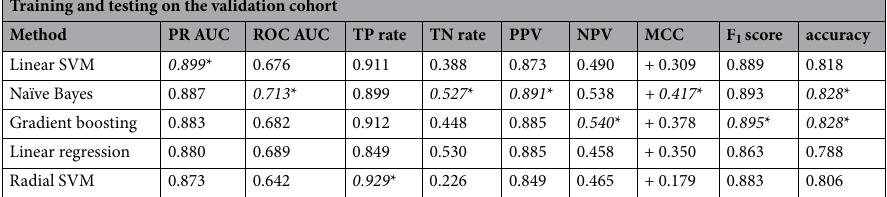
Table 6. Results of the survival prediction made with machine learning classifiers on the South Korean external validation cohort 96 . Mean results of 100 executions with random selection of the elements in the training set and test set, with ROSE oversampling 97 applied to the training set. In this analysis, both the training phase and the testing phase happened on the validation cohort. σ : standard deviation. Admissions of survived patients: positives data instances (class 1). Admissions of deceased patients: negative data instances (class 0). Linear SVM: support vector machine with linear kernel. Optimized cost regularization hyper- parameter of the linear SVM, most frequently selected C by the MCC-based grid search: C = 0.1 (59 times out of 100). Radial SVM: support vector machine with radial Gaussian kernel. Optimized cost regularization of the radial SVM, most frequently selected C by the MCC-based grid search: C = 0.1 (70 times out of 100). MCC: Matthews correlation coefficient. MCC worst value = − 1 and best value = + 1 . TP rate: true positive rate, sensitivity, recall. TN rate: true negative rate, specificity. PR: precision-recall curve. PPV: positive predictive value, precision. NPV: negative predictive value. ROC: receiver operating characteristic curve. AUC: area under the curve. F 1 score, accuracy, TP rate, TN rate, PPV, NPV, PR AUC, ROC AUC: worst value = 0 and best value = + 1 . ROSE p -value: 0.5 for all. We report the results with standard deviations in Table S2 and the formulas of the statistical indicators in the Supplementary Information. We highlighted in italic and with an asterisk * the top result for each statistical indicator.